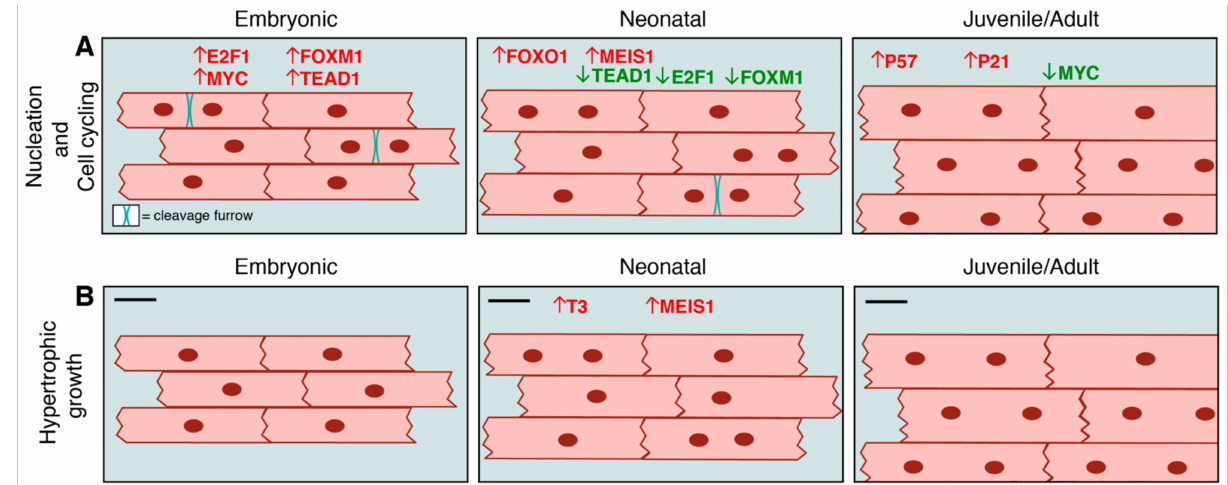
Figure 1. Transcriptional control of nucleation, cell cycling, and hypertrophic growth in embryonic, neonatal, and juve- nile/adult rodent cardiomyocytes. ( A ) Embryonic/fetal cardiomyocytes are primarily mononucleated and proliferate to drive cardiac growth prenatally due to high levels (red) of Tead1, E2f1, Foxm1, Myc. After birth, karyokinesis in the absence of cytokinesis increases as cardiomyocytes mature and become multinucleated. This is concomitant with the downregulation (green) of cell cycle promoting factors such as Tead1, E2f1, Foxm1, Myc; together with the upregulation (red) of cell cycle inhibitory factors such as Foxo1, Meis1, p57, p21. ( B ) Hypertrophic growth increases after birth with the induction of multinucleation. This is associated with increased levels of T3 thyroid hormone and Meis1 in adult cardiomyocytes. Refer to text for